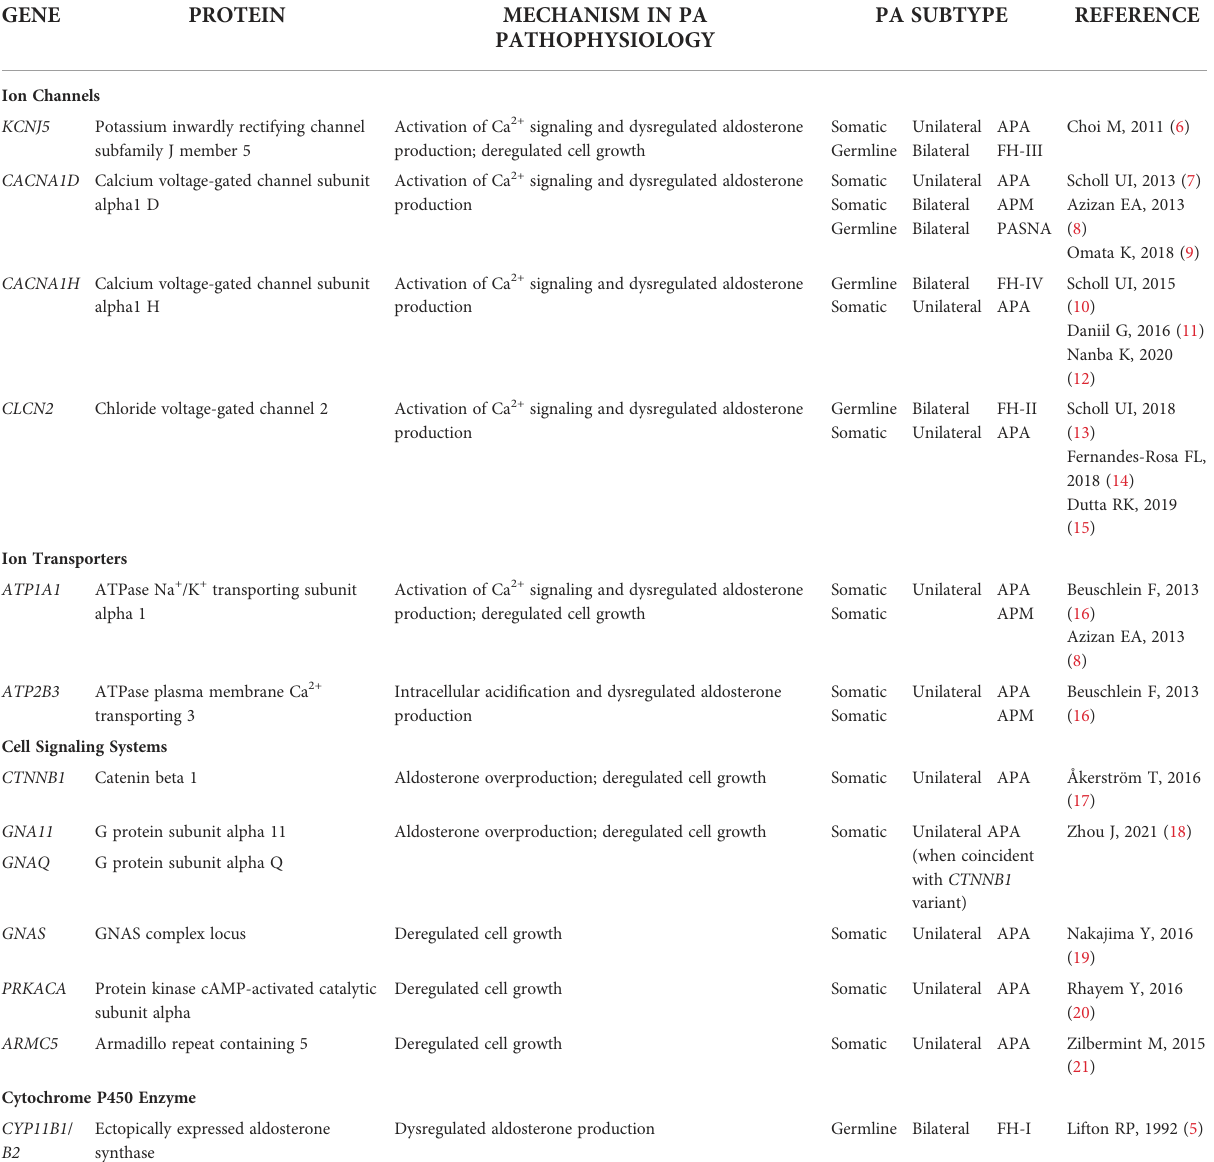
TABLE 1 Effect Of Gene Variants In Primary Aldosteronism Driver